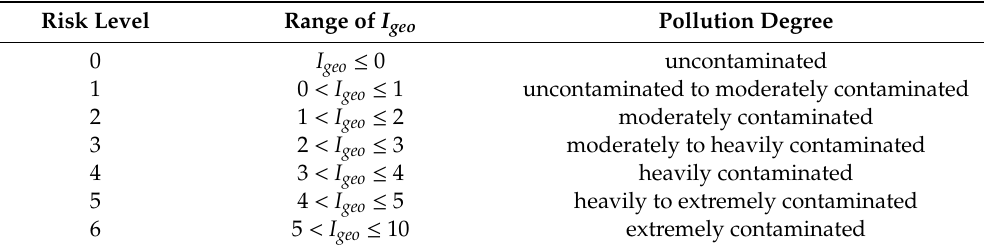
Table 1. Classification of heavy metal pollution in sediment based on I geo